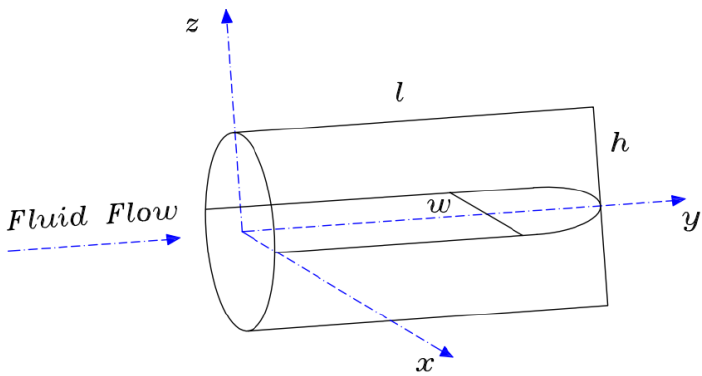
Figure 5. Structure of the PKN model of a hydraulic fracture: y -axis is the direction of fracture extension, w is the width of fracture, l is the length of fracture, and h is the height of fracture. The KGD model assumes two simple propagation models for the fracture extension: the radially symmetrical extension caused by a point source and rectilinear propagation originating from a line source. For the fracture width, the model employs the elasticity theory to describe the width of fractures and an arbitrary normal stress. The significant characteristic of the KGD models is that the linearly expanding fractures are assumed to possess plane strain conditions, and the height of the fracture is not assumed as constant. The structure of the KGD methods is shown in Figure